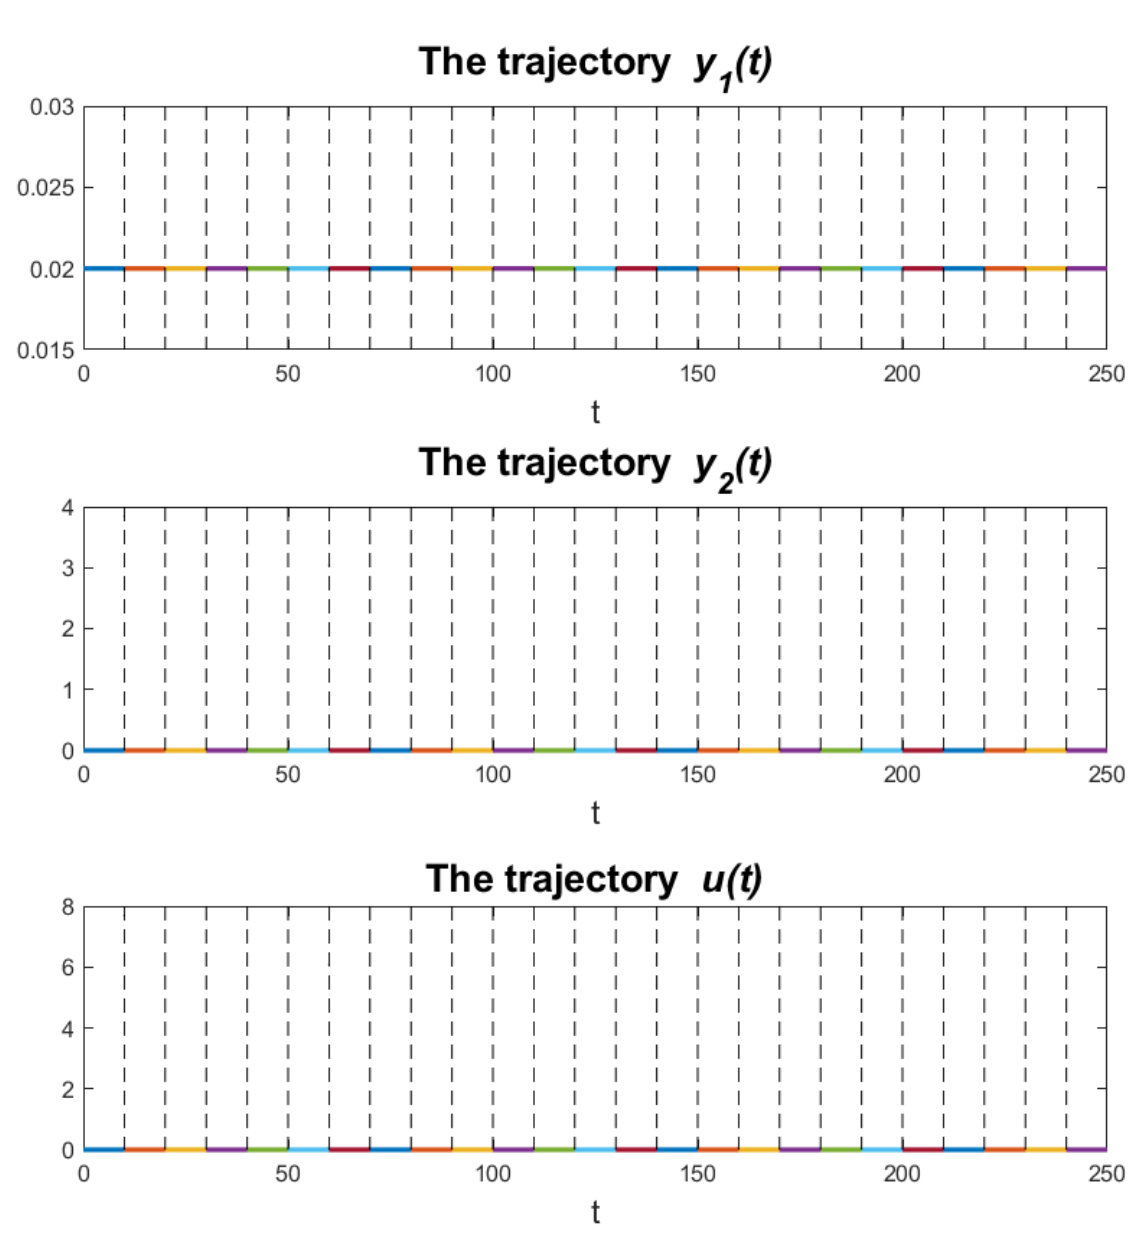
Figure 2. The obtained solution trajectories for u ( t ) =